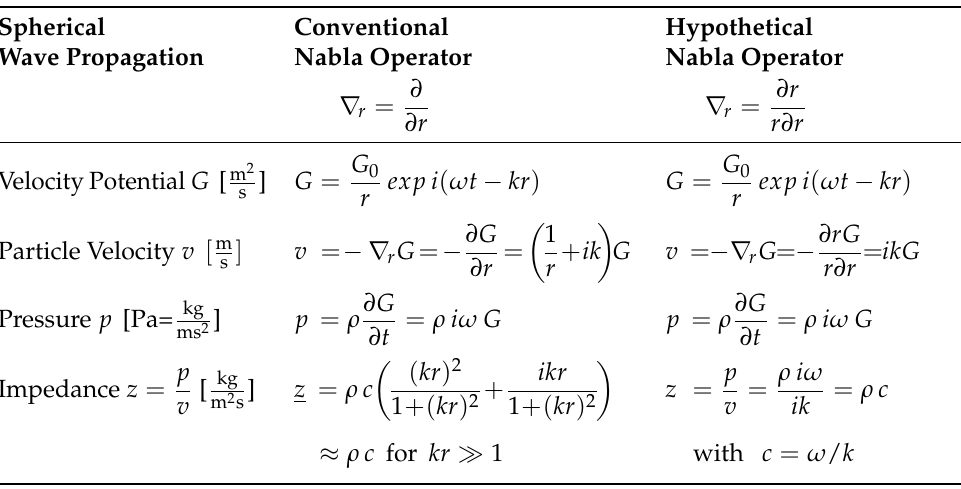
Table 4. Calculation of particle velocity, pressure and specific impedance z = p / v of a spherical wave with velocity potential G using different Nabla operators. For the conventional Nabla operator ∇ r Φ = ∂ Φ / ∂ r [7] follows a complex impedance, wheras for the hypothetical Nabla